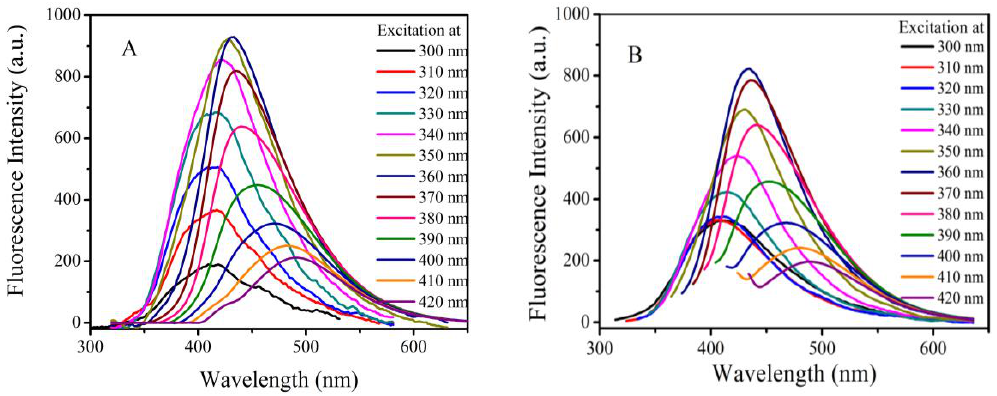
Figure 2. Fluorescence emission spectra of FCNs obtained at different excitation wavelengths without metronidazole ( A ) and adding metronidazole (15 μM) ( B ).